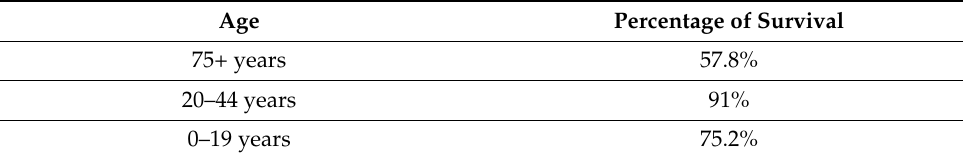
Table 3. Survival rates of ependymoma [33,46].